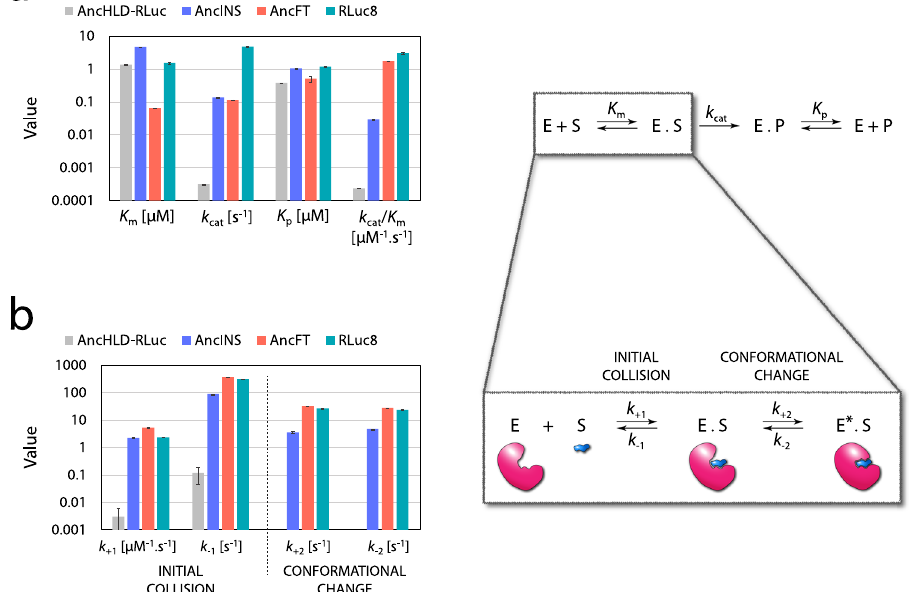
Fig. 3 Steady-state and transient kinetic analysis of CTZ conversion. The kinetic models consist of an enzyme E, a substrate S, an enzyme-substrate complex in two conformations (E.S and E*.S), an enzyme-product complex E.P, and a product P. a Steady-state kinetic parameters (Michaelis constant K m , turnover number k cat , enzyme-product complex dissociation constant K p ) were determined with the substrate CTZ in 100 mM phosphate buffer at pH 7.5 and 37 °C by global analysis of triplicates of full progress curves recorded with at least fi ve concentrations of CTZ. b Results of pre-steady-state kinetic analysis of the CTZ substrate binding in 100 mM phosphate buffer at pH 7.5 and a lower temperature (15 °C). This enabled identi fi cation of the induced fi t substrate binding mechanism, involving initial collision of the enzyme and the substrate (described by forward rate constant k + 1 and reverse rate constant k − 1 ), followed by a conformational change of the enzyme induced by the bound substrate (described by forward rate constant constant k − 2 ). A simple binding mechanism including only the fi rst step was observed for Anc HLD-RLuc . The kinetic parameters were determined by global fi tting of tryptophan fl uorescence traces obtained with at least 10 concentrations of CTZ and 10 concentrations of each tested enzyme, in each case with seven replicates (Supplementary Note 6). The data are presented as best fi t values ± standard errors (S.E.) calculated from the covariance matrix during nonlinear regression. Source data is available as a Source data fi le for Fig.